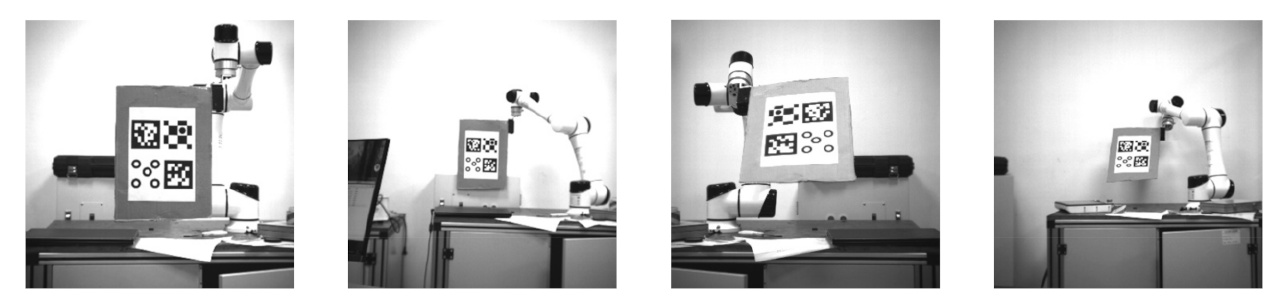
Figure 10. The 0 ◦ and 45 ◦ angular position images at 2 and 4 m.